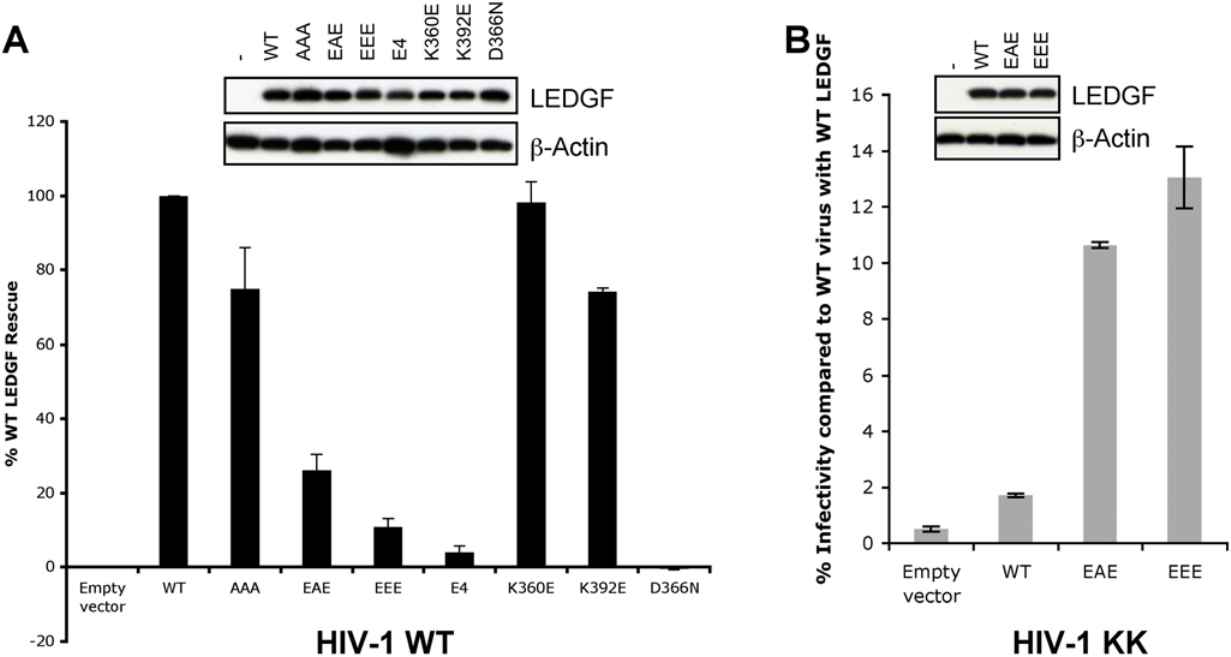
Figure 5. LEDGF Residues Lys-401, Arg-404, and Arg-405 Play a Crucial Role in HIV-1 Infection. (A) Relative infectivity of VSV G- pseudotyped WT HIV-Luc virus on Ledgf -null E2 MEFs transfected with human WT, AAA, EAE, EEE, E4, or D366N LEDGF expression vectors, as indicated. Infectivity of the virus in the presence of WT LEDGF was set to 100%; mean values and standard deviations combine data of two independent sets of transfections (each with infections performed in duplicate). (B) Infectivity of HIV-Luc bearing KK mutations in IN on E2 MEFs transfected with WT, EAE, or EEE LEDGF. Infectivity is expressed as a percentage of WT virus on the cells transfected with WT LEDGF. Western blots above the graphs show expression levels of LEDGF proteins and actin loading